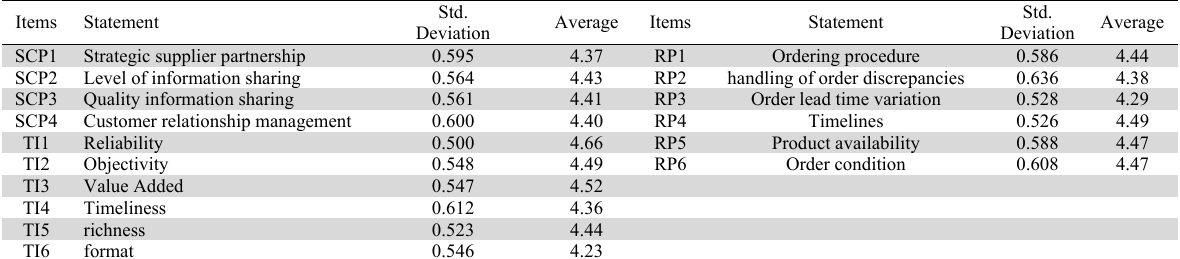
Descriptive analysis result